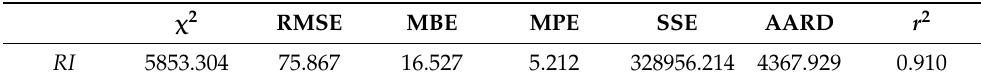
Table 6. Goodness of fit of the ANN